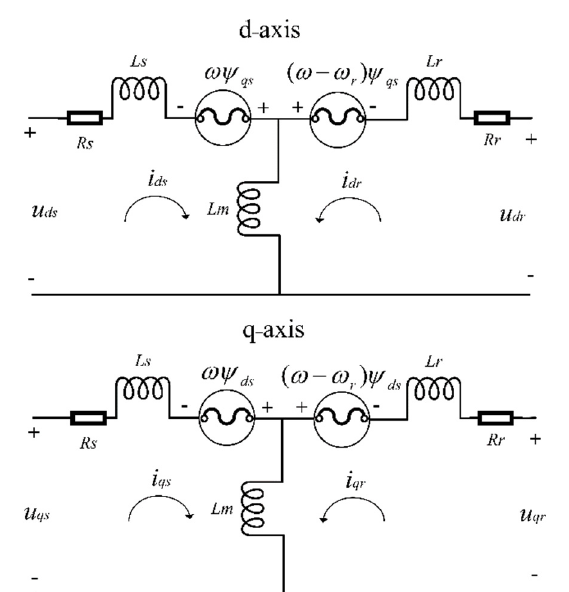
Figure 4. Motor equivalent circuit in d − q coordinate system.